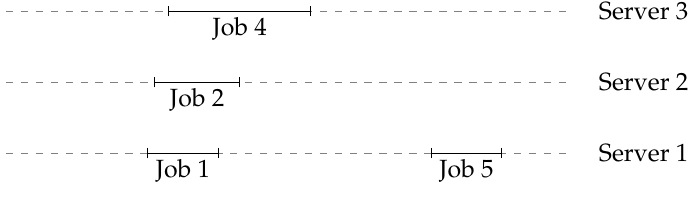
Figure 3. Assignment of jobs in the instance presented in Table 1 by Algorithm D